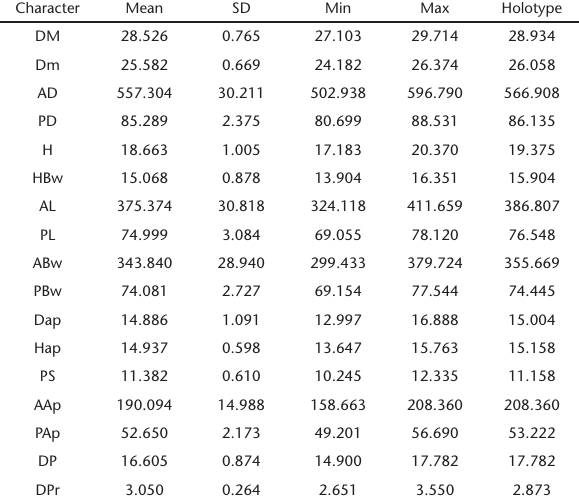
Table 1. Shell dimensions in mm or mm 2 (n = 14). DM major di- ameter, Dm minor diameter, AD dorsal area, PD dorsal perimenter, H total height, HBw body whorl height, AL lateral area, PL lateral perimeter, ABw body whorl area, PBw body whorl perimeter, Dap diameter of the aperture, Hap height of the aperture, EP length parietal space, AAp apertural area, Pap apertural perimeter, DP penultimate whorl diameter, DPr protoconch diameter (see Fig.